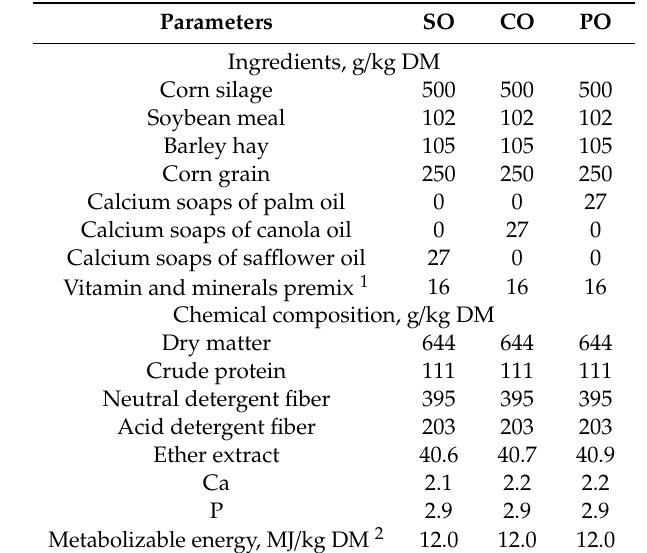
Table 2. Ingredients and chemical composition of sa ffl ower oil (SO), canola oil (CO) and palm oil (PO) treatments in dairy goat